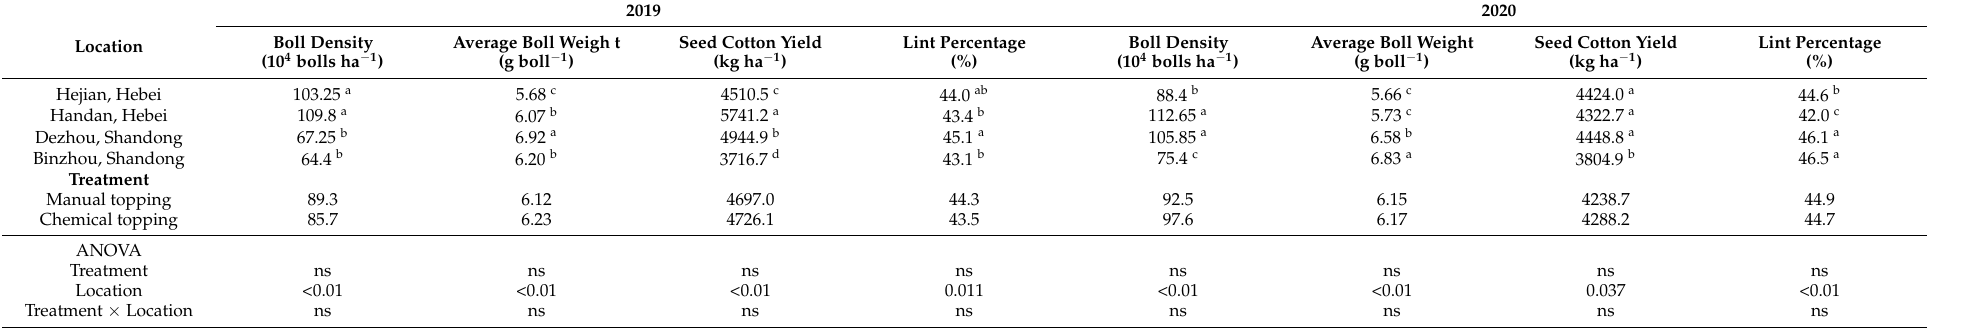
Table 3. Effect of manual (MT) and chemical topping (CT) on seed cotton yield, and yield components in 2019 and 2020